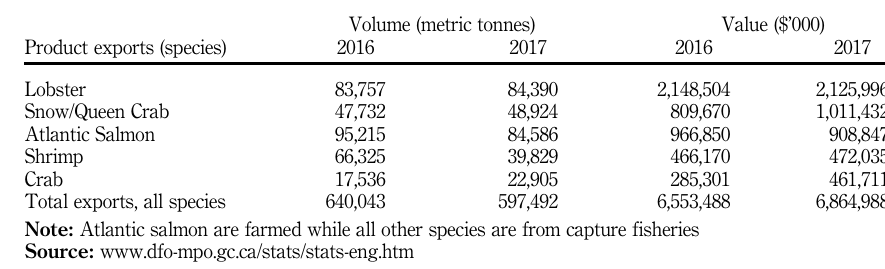
Table V. International trade in fish and seafood